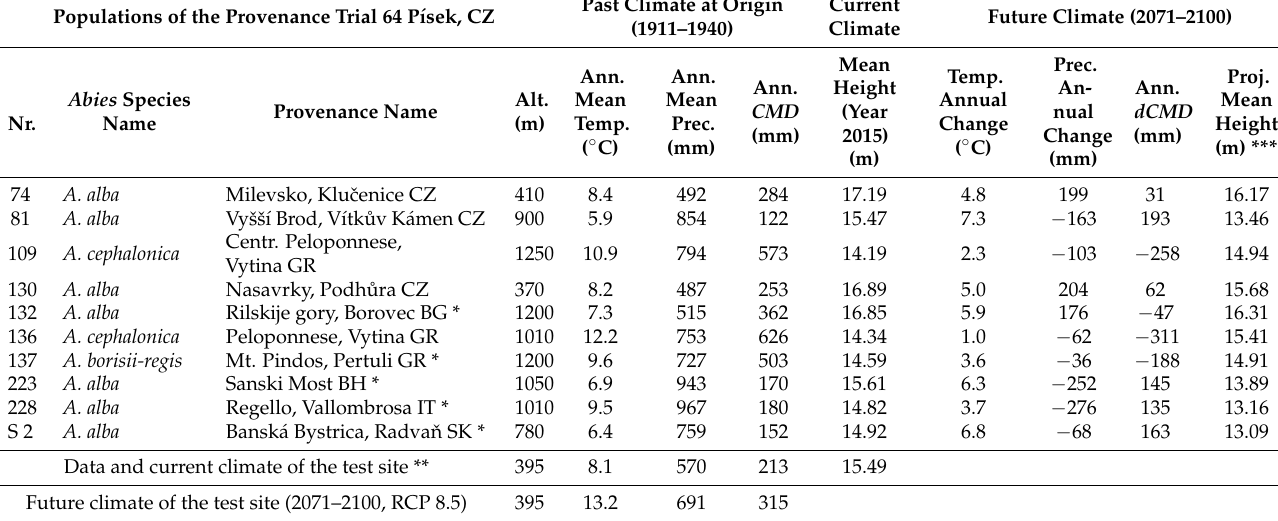
Table A3. Climate parameters and heights of silver and Balkan firs in past, current and projected climates and heights in the P í sek trial (see also Figure